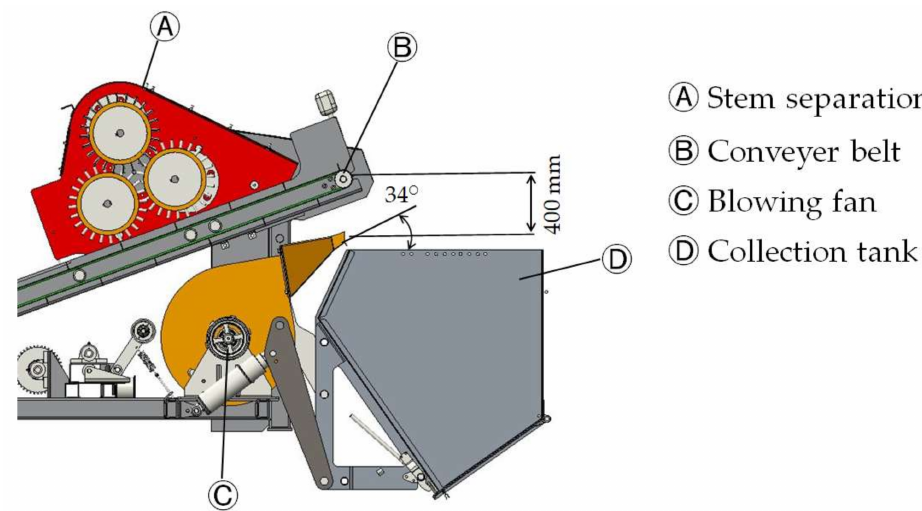
Figure 2. Components of a separation system for foreign